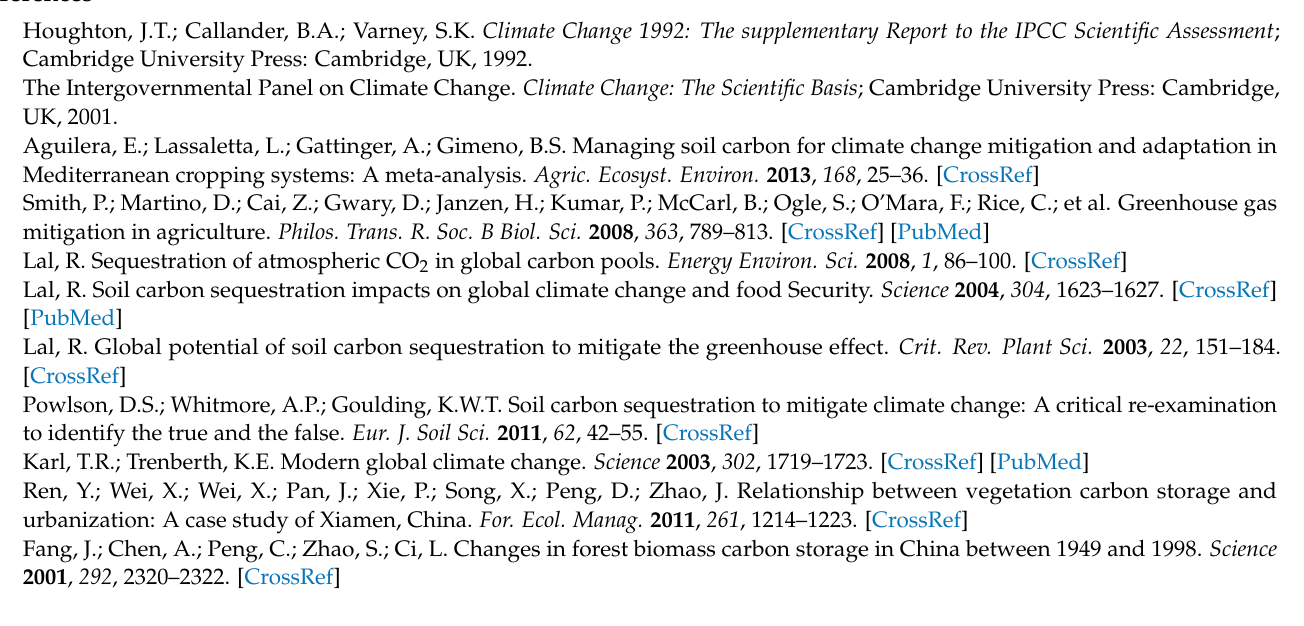
Table S1: Accuracy assessment of land use classification of five capitals in 2009, Table S2: Accuracy assessment of land use classification of five capitals in 2019, Table S3: The neighborhood weights for six land use types in five capitals, Table S4: Conversion cost matrix of land use pairs under three scenarios, Table S5: Two uncertainties in estimating carbon storage impacts of future land use